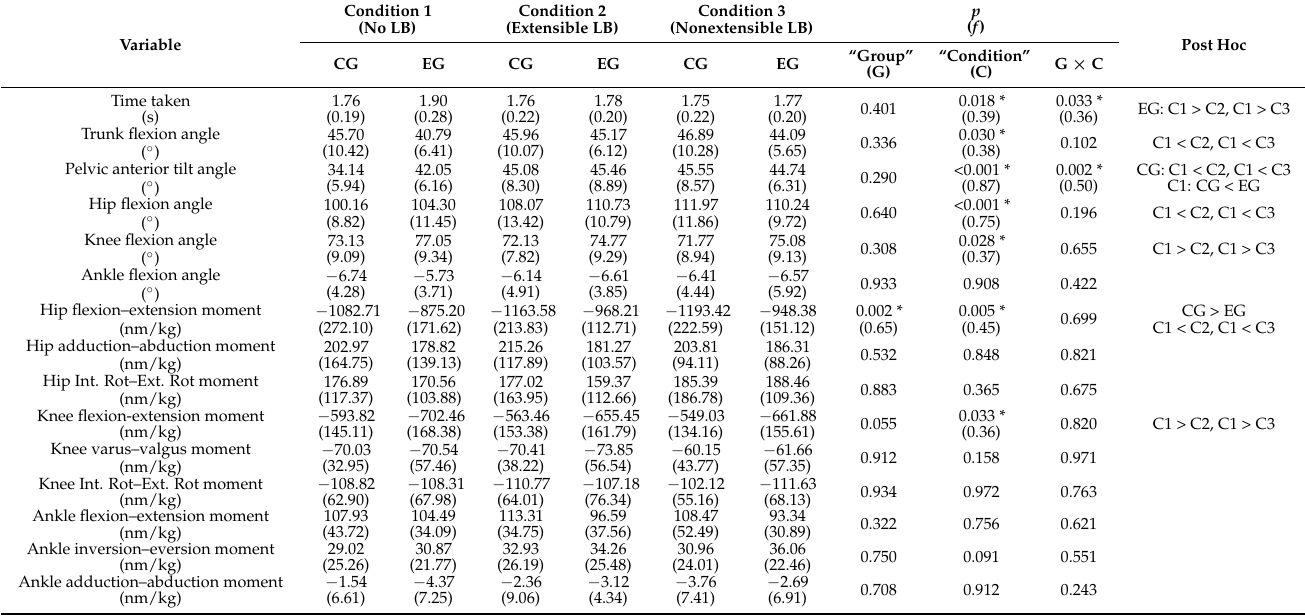
Table 2. Analysis of the time taken, kinematics, and kinetics variables for the sit-to-stand motion according to the experimental conditions.